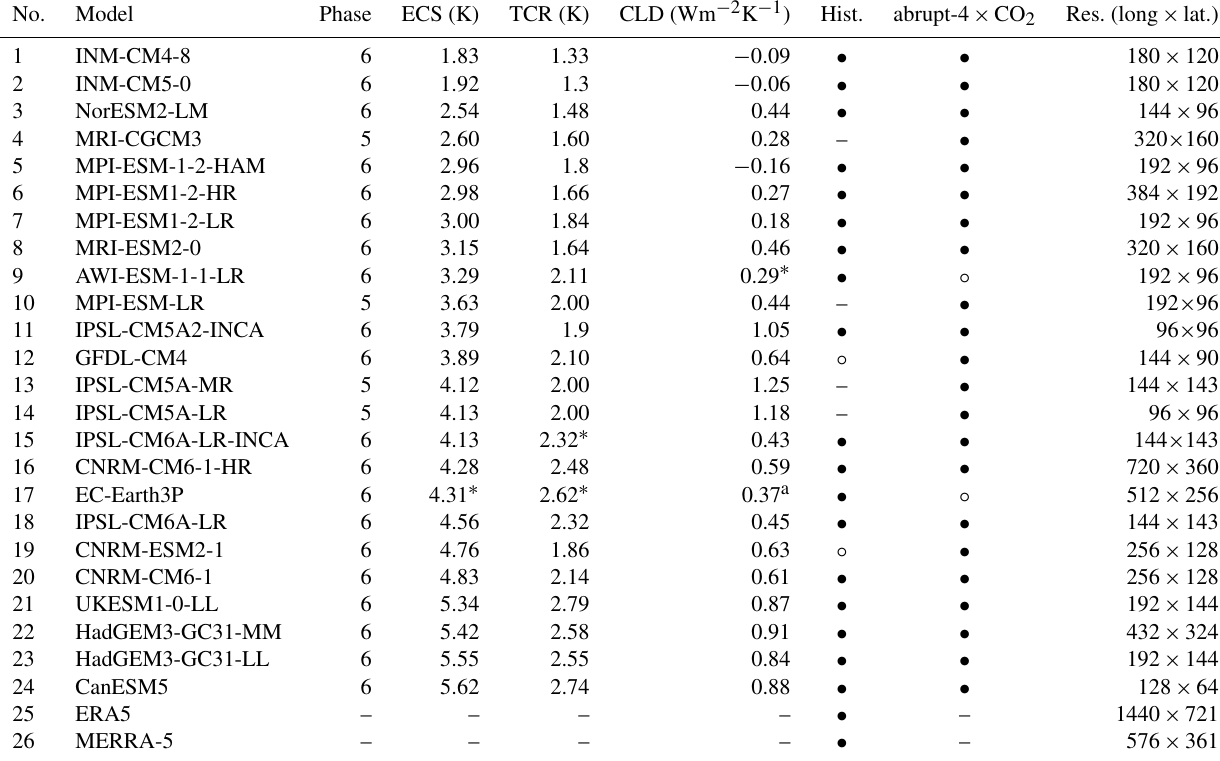
Table 1. Table of CMIP5 and CMIP6 models and reanalyses used in our analysis and their CMIP phase, equilibrium climate sensitivity (ECS), transient climate response (TCR) and cloud feedback (CLD), if they provided the necessary variables in the historical (“Hist.”) (in the case of reanalyses, historical reanalysis) and abrupt-4 × CO 2 experiments (“ • ” – yes, “ ◦ ” – no, “–” – not applicable), and model output resolution (“Res.”) as the number of longitude × latitude bins. Models are sorted by their ECS. ECS, TCR and CLD were sourced from AR6, Zelinka (2021) and Semmler et al.